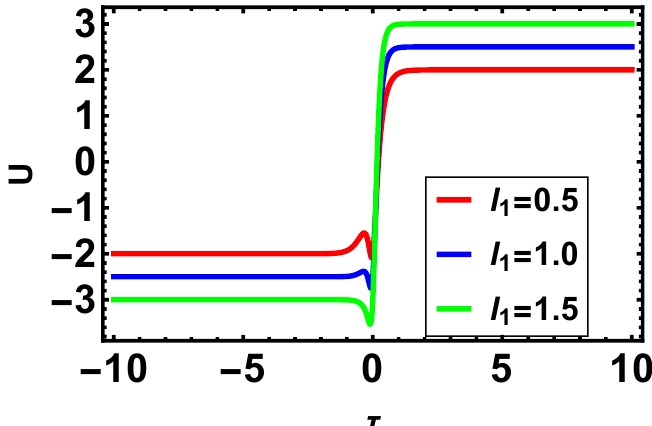
Figure 10. Comparison of different values if l 1 .